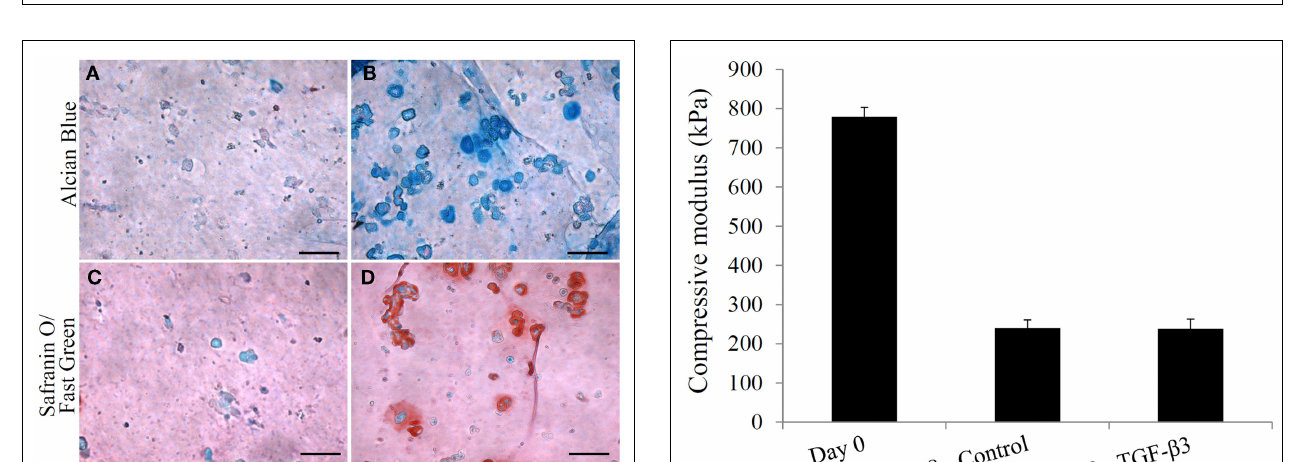
FIGURE 6 | Immunohistochemical staining for collagen type II in hASC-encapsulated VL-PSL-fabricated constructs . (A) Day 0 immediately after fabrication; (B) day 28 control group; and (C) day 28 TGF- β 3 group. Positive collage type II staining (brown) was only seen in the day 28 TGF- β 3 treated group as indicated by arrows. Scale bar: 50 μ m.